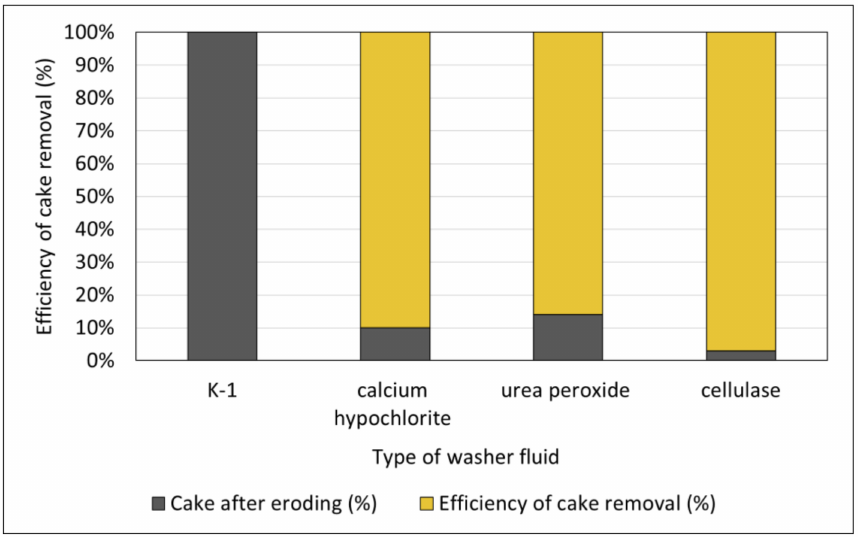
Figure 14. The efficiency of the removal of filter cakes produced from the drilling mud taken from the K-1 borehole, depending on the fluids used for